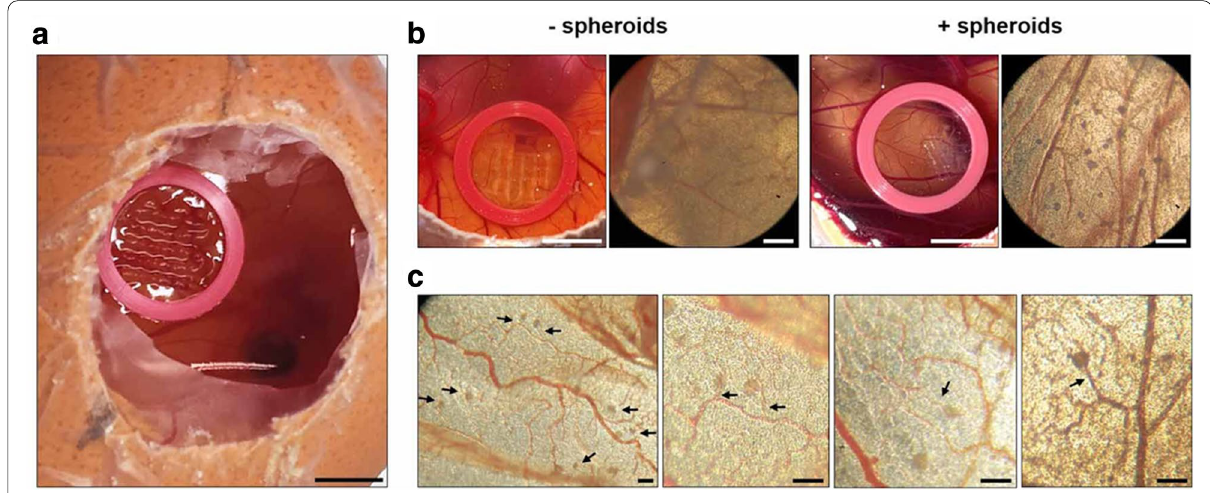
Fig. 8 Functional evaluation of prevascularized spheroid‑laden bioprinted scaffolds by a CAM‑assay a Overview of bioprinted sample on the CAM, scale bar spheroid‑laden scaffolds on the CAM. Overview scale bars on the CAM. Branching of CAM microvessels and inosculation of CAM microvasculature with the spheroids (indicated by the black arrows). Scale bars 200 µm. Reprinted with permission from Biofabrication =